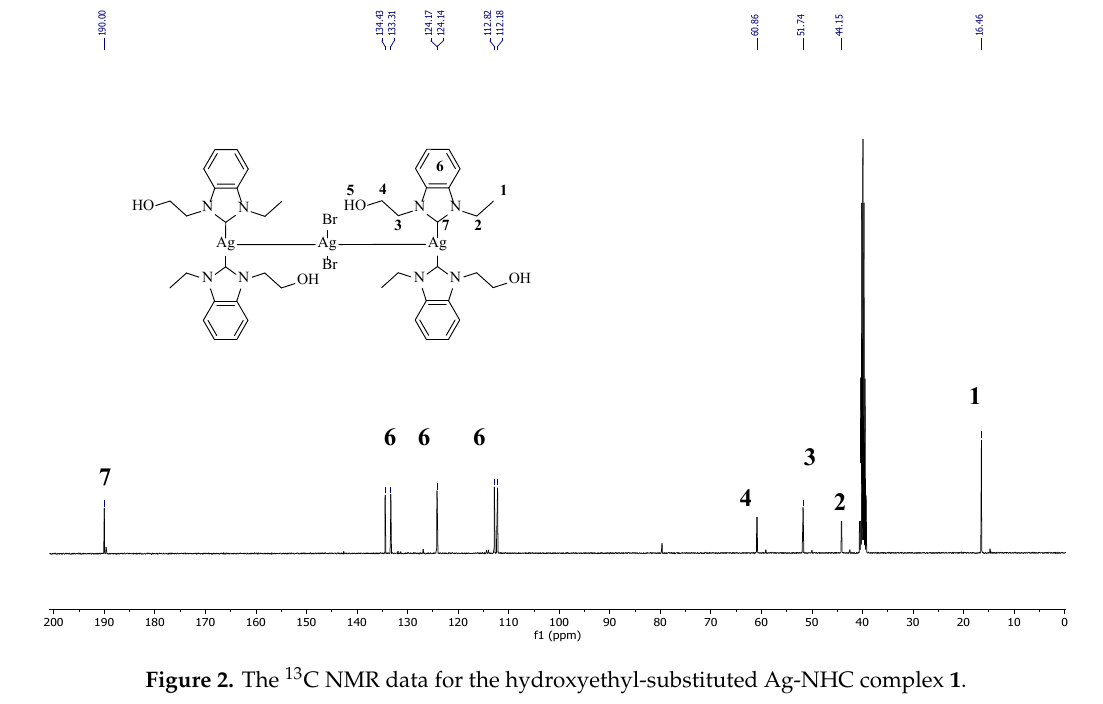
Figure 2. The 13 C NMR data for the hydroxyethyl-substituted Ag-NHC complex 1. Crystals 2020 , 10 , x FOR PEER REVIEW